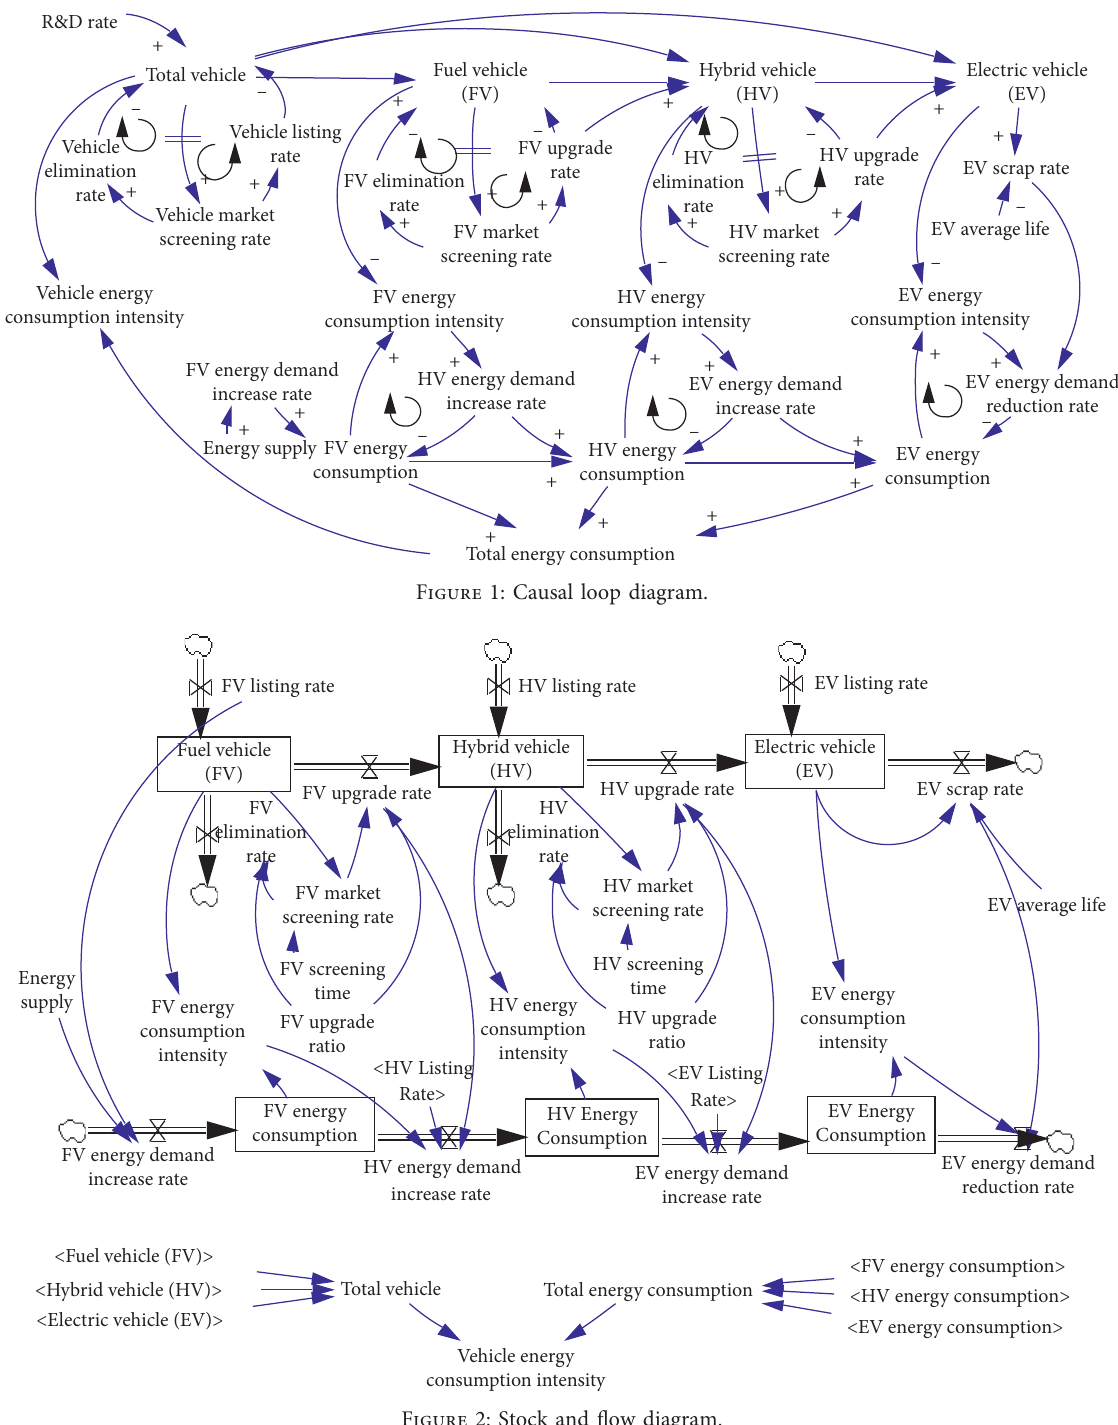
Figure 2: Stock and flow